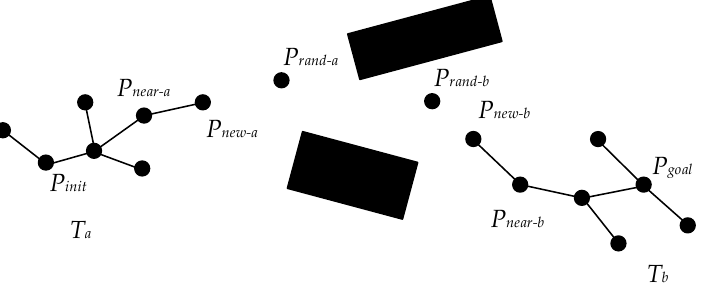
Figure 1. Schematic diagram of basic Bi-RRT expansion.